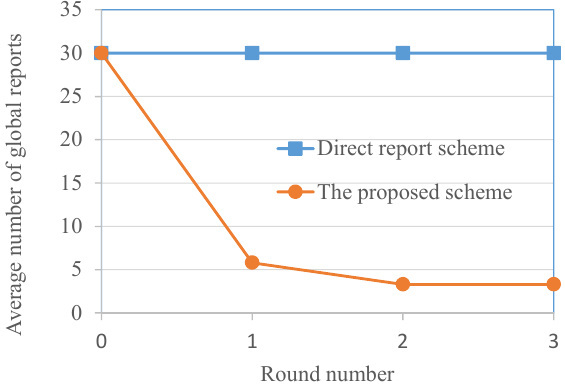
Figure 9. Average report number in Scenario